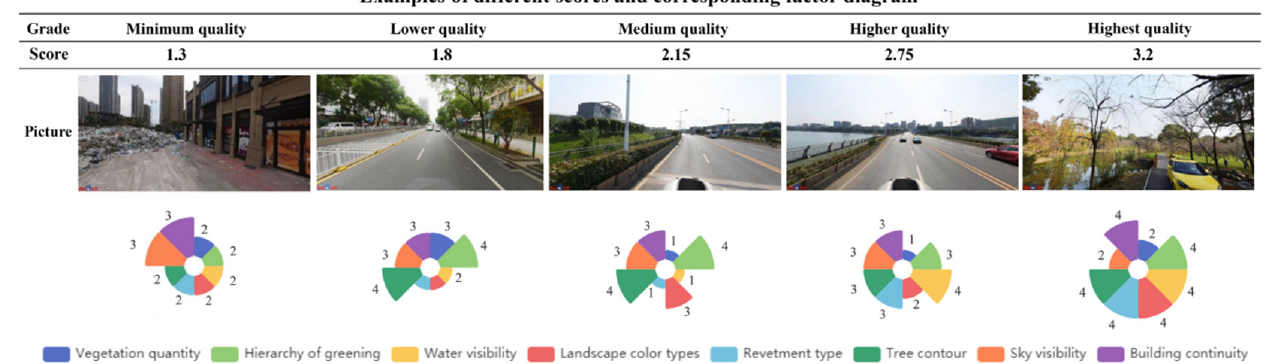
Figure 6. Schematic of grading result.